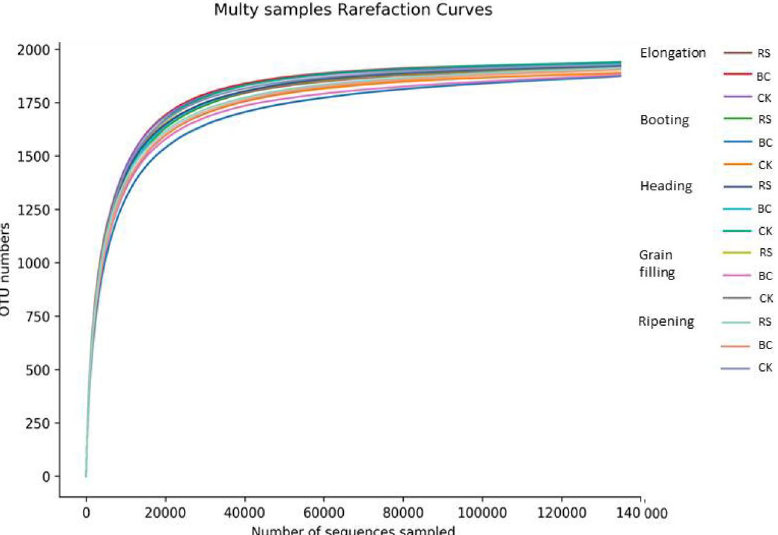
Figure 1. Rarefaction on species-abundance data. Treatments: RS rice straw applied at 9000 kg ha −1 , BC biochar applied at 3150 kg ha −1 , CK soil without straw/biochar application.